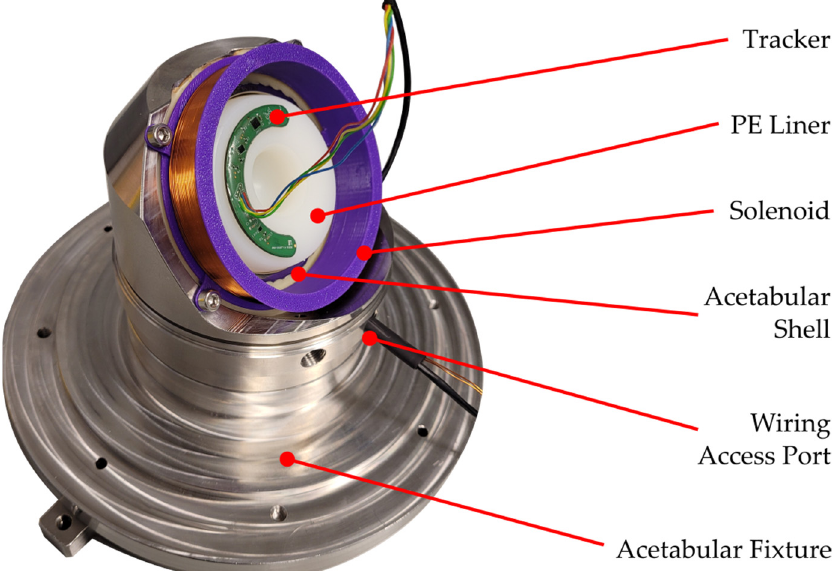
Figure 5. Photograph of the tracker and solenoid mounted to a DM implant cemented into the acetabular fixture used for in vitro testing with the key features labelled. The tether from the tracker passes between the solenoid and the wall of the fixture and out through the access port along with the power for the solenoid.